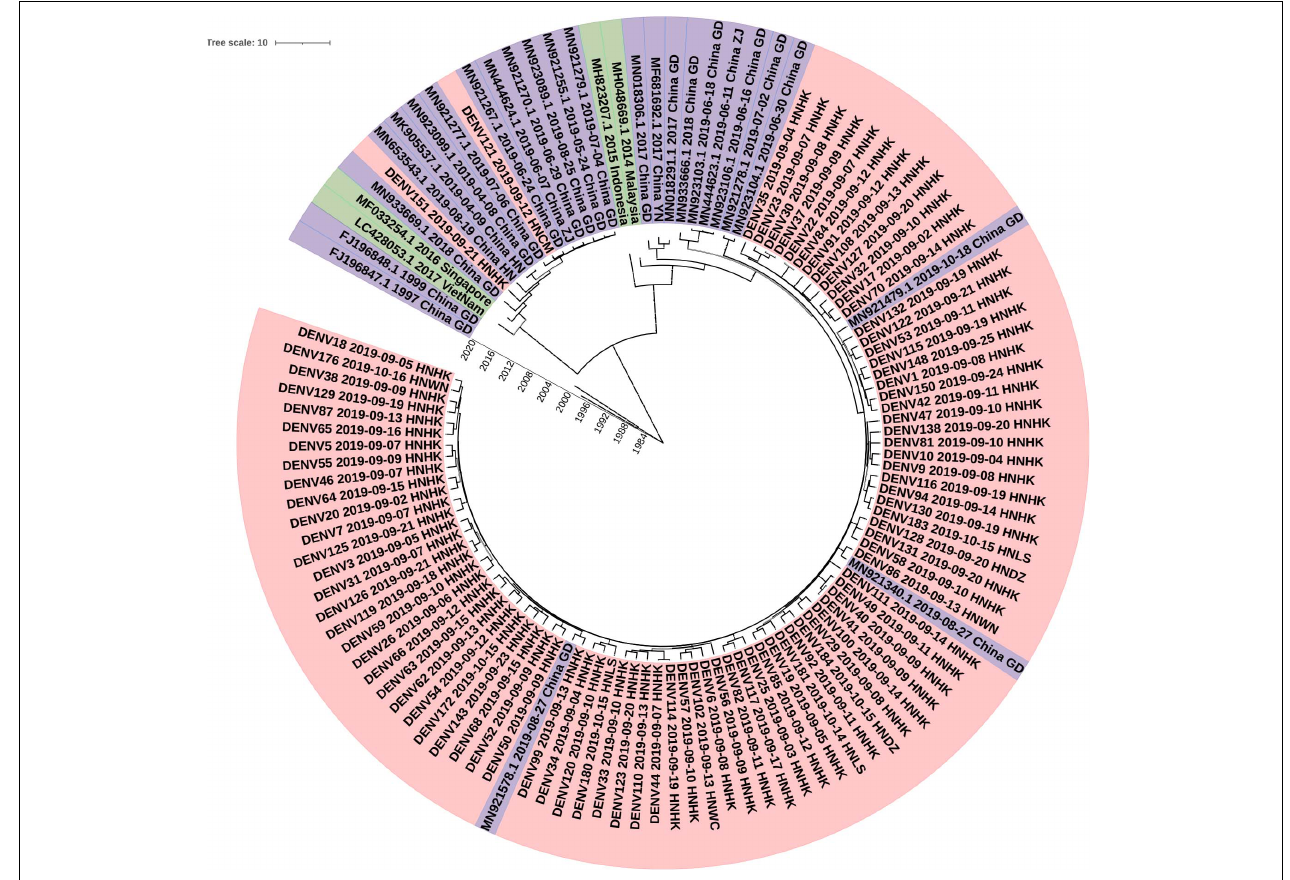
FIGURE 4 | Phylogenetic tree of DF-1 by E gene sequences. China GD, Guangdong Province in China; China YN, Yunnan Province in China; China ZJ, Zhejiang Province in China; China HN, Henan Province in China; HNHK, Haikou city Hainan Province in China; HNCM, Chengmai city Hainan Province in China; HNDZ, Danzhou city Hainan Province in China; HNLS, Lingshui city Hainan Province in China; HNWN, Wanning city Hainan Province in